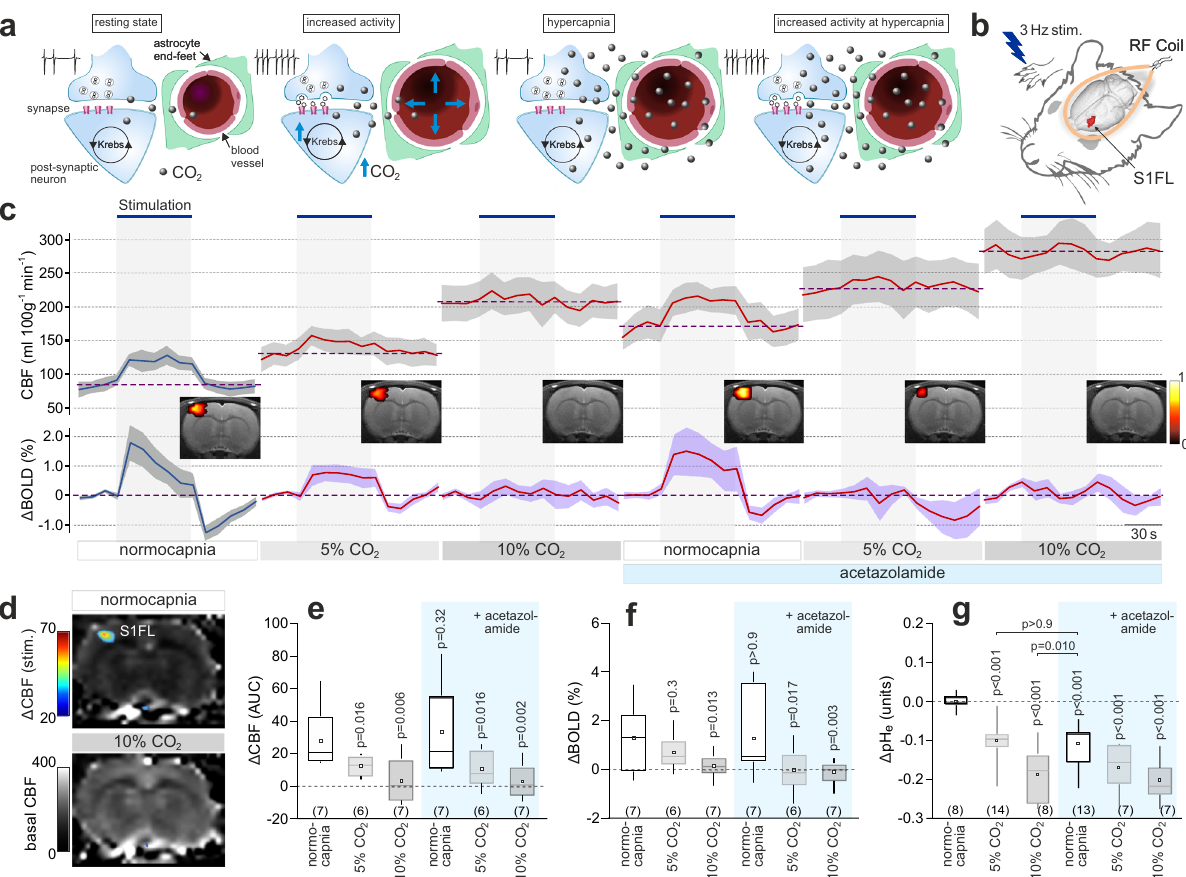
Fig. 2 Exogenous CO 2 prevents the development of the neurovascular response in the somatosensory cortex in rats. a Schematic depiction of the neurovascular unit illustrating the central hypothesis and the experimental approach taken to study the potential role of CO 2 as a signaling molecule that mediates the neurovascular coupling response. A surplus of exogenous CO 2 was given in the inspired air (hypercapnia) in order to saturate the brain CO 2 - sensitive vasodilatory mechanism. If the hypothesis is correct, then in the presence of surplus of exogenous CO 2 , any extra metabolic CO 2 generated as a result of increased neuronal activity should have no additional effect on local cerebral blood fl ow (CBF) and the neurovascular response should be blocked. If the mechanisms other than CO 2 signaling mediate the neurovascular coupling response, then the response should not be affected by the excess of exogenous CO 2 . b CBF and blood oxygen level dependent (BOLD) signals in the forepaw region of the somatosensory cortex (S1FL) in anesthetized rats were recorded using an arterial spin labeling (ASL) sequence with T2* weighted imaging. Somatosensory pathways were activated by electrical stimulation of the forepaw. RF radiofrequency. c CBF and BOLD responses in the S1FL region induced by electrical forepaw stimulation (3 Hz, 1.5 mA) at baseline, in conditions of 5% and 10% inspired CO 2 , after the administration of carbonic anhydrase inhibitor acetazolamide (10 mg kg − 1 , i.v.), and in conditions of 5% and 10% inspired CO 2 , applied concomitantly with systemic carbonic anhydrase inhibition with acetazolamide. Data are presented as mean values± SEM (shaded areas denote error bands). Insets show representative activation maps illustrating mean BOLD signal changes in response to somatosensory stimulation. Color bar: t -score from statistical paramagnetic mapping mixed-effects analysis, p < 0.05 (uncorrected). d Representative ASL images illustrating CBF at rest (normocapnia) and in conditions of 10% inspired CO 2 . Overlaid (false color scale) illustrates CBF response in the S1FL region induced by forepaw stimulation. e , f Summary data illustrating the effect of 5% and 10% inspired CO 2 , given before and after systemic administration of acetazolamide, on CBF and BOLD responses recoded in the S1FL region of the cortex. P values, mixed-model ANOVA followed by Holm – Sidak multiple comparison test. g Summary data illustrating peak changes in brain tissue pH (S1FL cortical region) following administration of acetazolamide, as well as in response to 5% and 10% inspired CO 2 , given before and after systemic administration of acetazolamide. P values, Kruskal – Wallis test followed by Dunn ’ s multiple comparison test. In the box-and-whisker plots the central dot indicates the mean, the central line indicates the median, the box limits indicate the upper and lower quartiles, and the whiskers show the minimum – maximum range of the data. Numbers in parentheses indicate sample sizes (number of animals per experimental group). Source data are provided as a Source Data fi